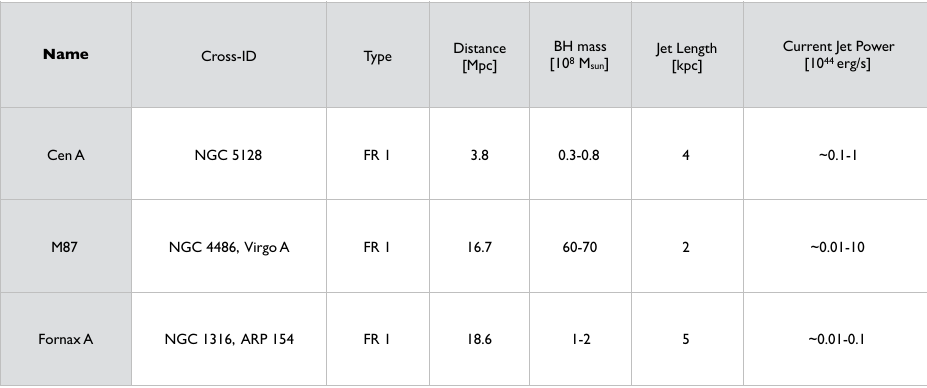
Figure 7. The three nearest radio galaxies, considered to be UHECR prime candidate sources, along with values for their black hole mass, typical (projected) jet lengths and estimates for the “current” jet power. The latter are somewhat uncertain and model-dependent. Cross-IDs give their alternative source